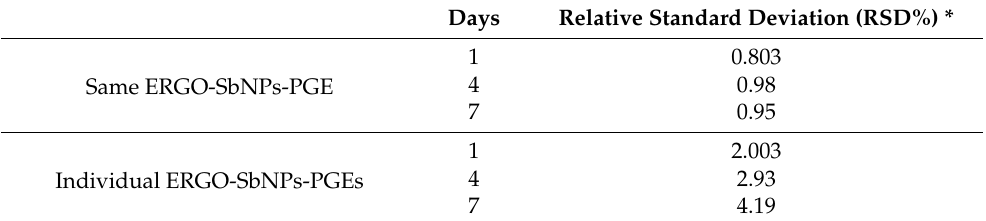
Figure 6. Bar graph of peak current measurements obtained on the same ( A ) and individual ( B ) ERGO-SbNPs-PGEs in 10 µmol·L −1 PC solution in 0.1 mol·L −1 phosphate buffer solution for repeatability, reproducibility, and stability over day 1, day 4, and day 7. Table 1. The results below show the RSD% of peak currents obtained on specific days of experiments (1, 4, and 7) conducted on the same and individual ERGO-SbNPs-PGEs to investigate reproducibility, repeatability, and stability.